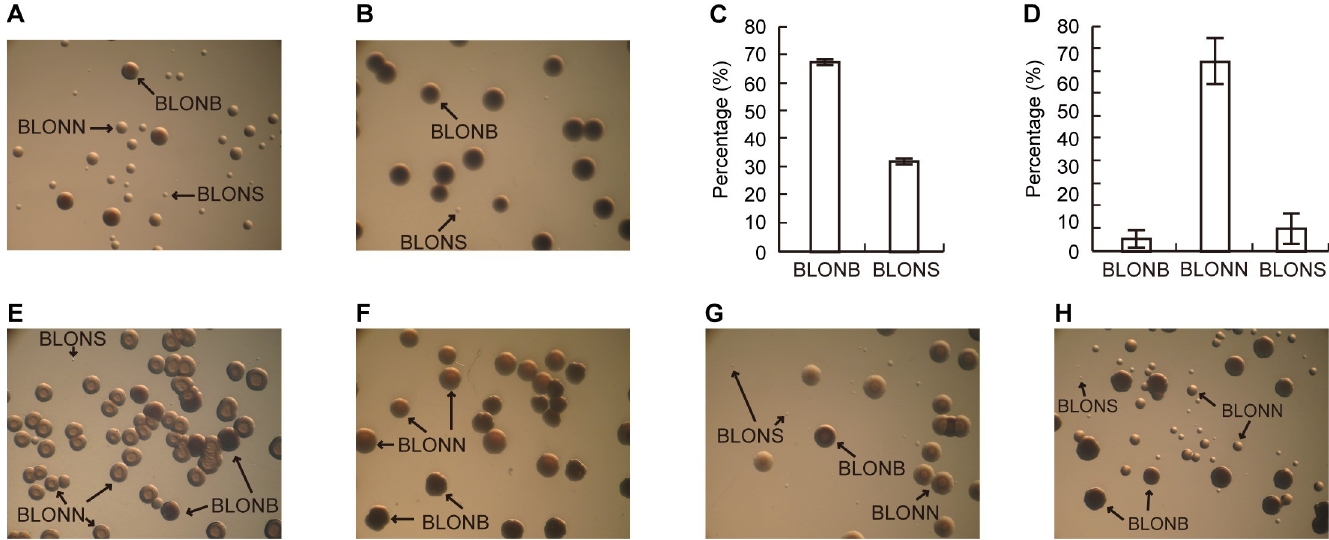
Fig 1. Segregation of morphologically distinct colony types from the lon mutant. (A) The lon mutant was segregated into three morphologically distinct colony types, big (BLONB), normal (BLONN), and small (BLONS). Colonies were grown in LB medium and observed under a dissecting microscope at × 30 magnification. (B) The BLONB segregated into BLONB and BLONS after subculture in LB medium. Colonies were observed under a dissecting microscope at × 30 magnification. (C) The BLONB and BLONS that had segregated from BLONB subcultured in LB medium accounted for 67.5% and 32.5% of the total population, respectively. (D) When the BLONN was subcultured in LB medium, 5.35%, 84.52%, and 10.13% of cells segregated into BLONB, BLONN, and BLONS types, respectively. The colony morphology of BLONN subcultured in (E) M9 minimal medium supplemented with 0.2% glucose, (F) nutrient broth medium, (G) King’s B medium, (H) LB supplemented with 100 mM HEPES (pH